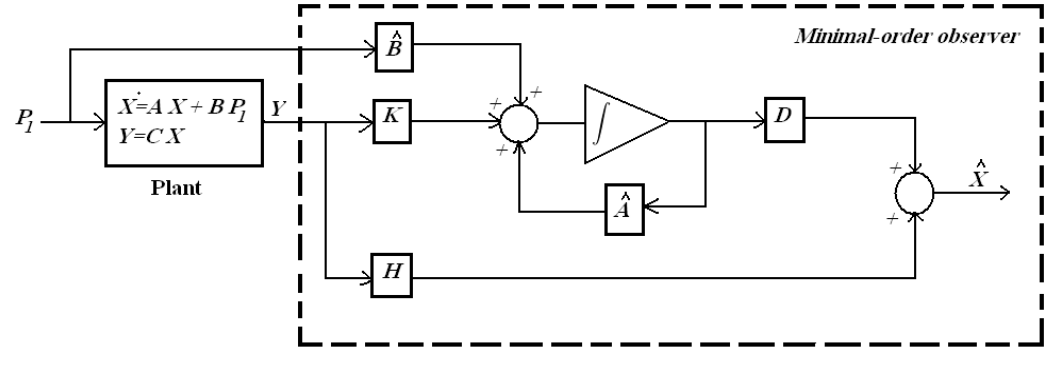
Figure 4. Minimal-order